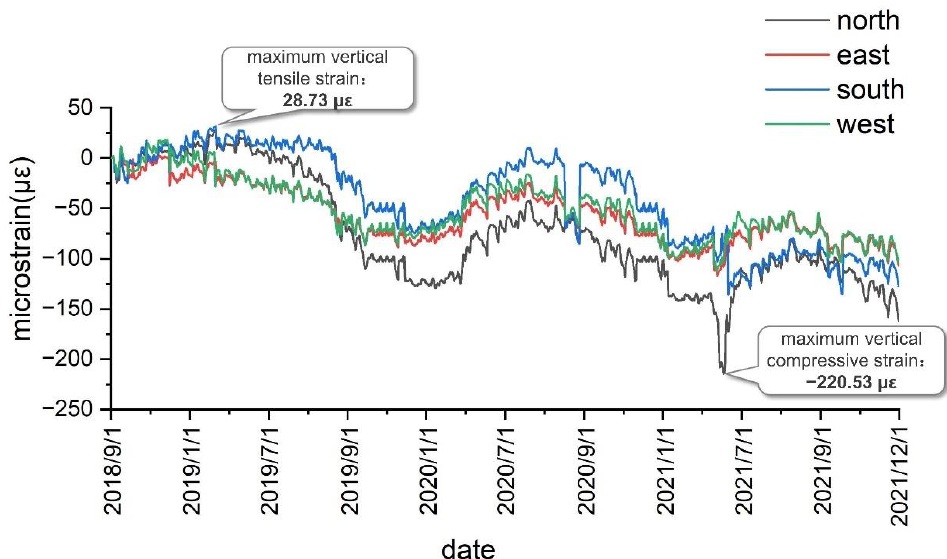
Figure 12. Measured vertical strain curves at first monitoring level.